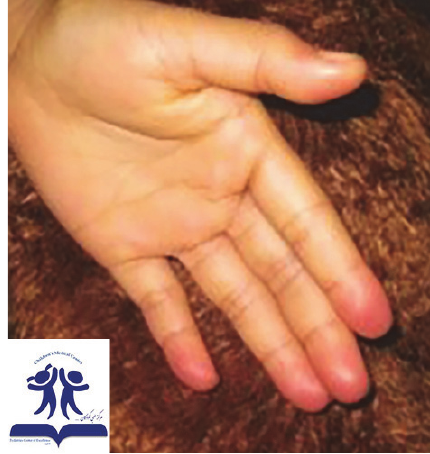
Figure 2: A 9-year-old girl with Nicolau syndrome after injection of benzathine penicillin in the deltoid muscle. Hyperemia and redness of the tips of the fingers of the left hand.